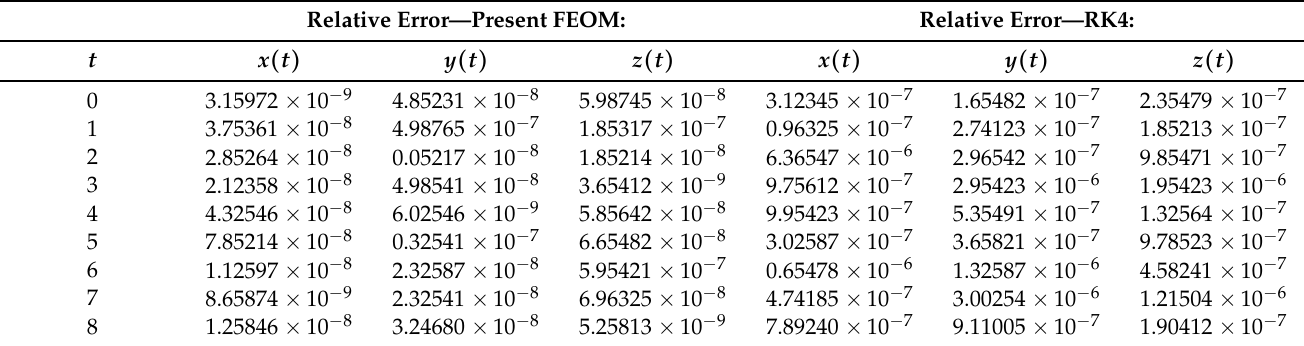
Table 1. Comparison of the REF between FEOM and RK4